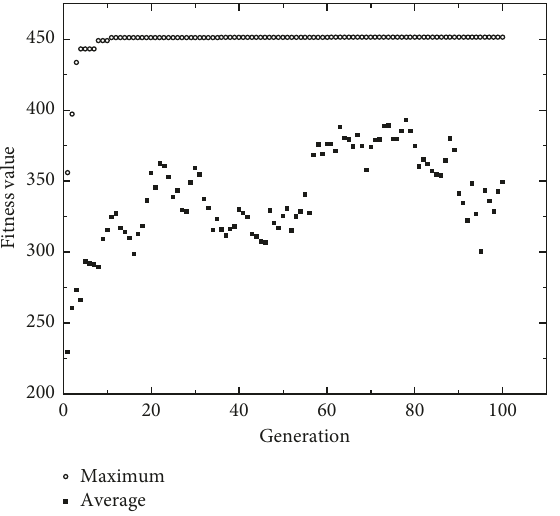
Figure 11: The fitness values versus